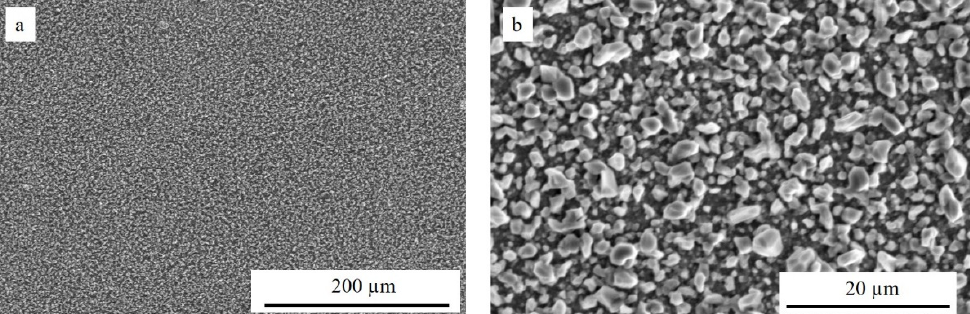
Figure 11. Secondary electron image of the surface of the polished sample after 100 h aging at 800 °C under laboratory air: ( a ) global view and ( b ) magnification.